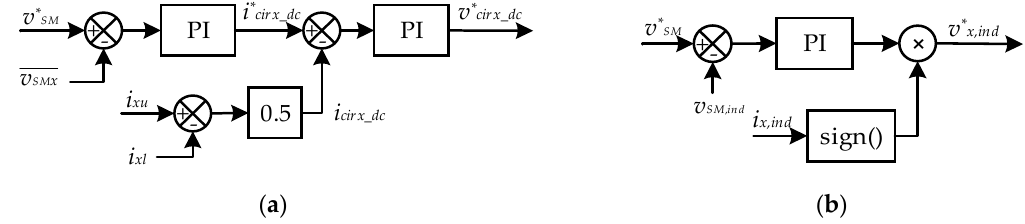
Figure 11. Voltage balancing control: ( a ) Leg voltage balancing; ( b ) Individual voltage balancing.